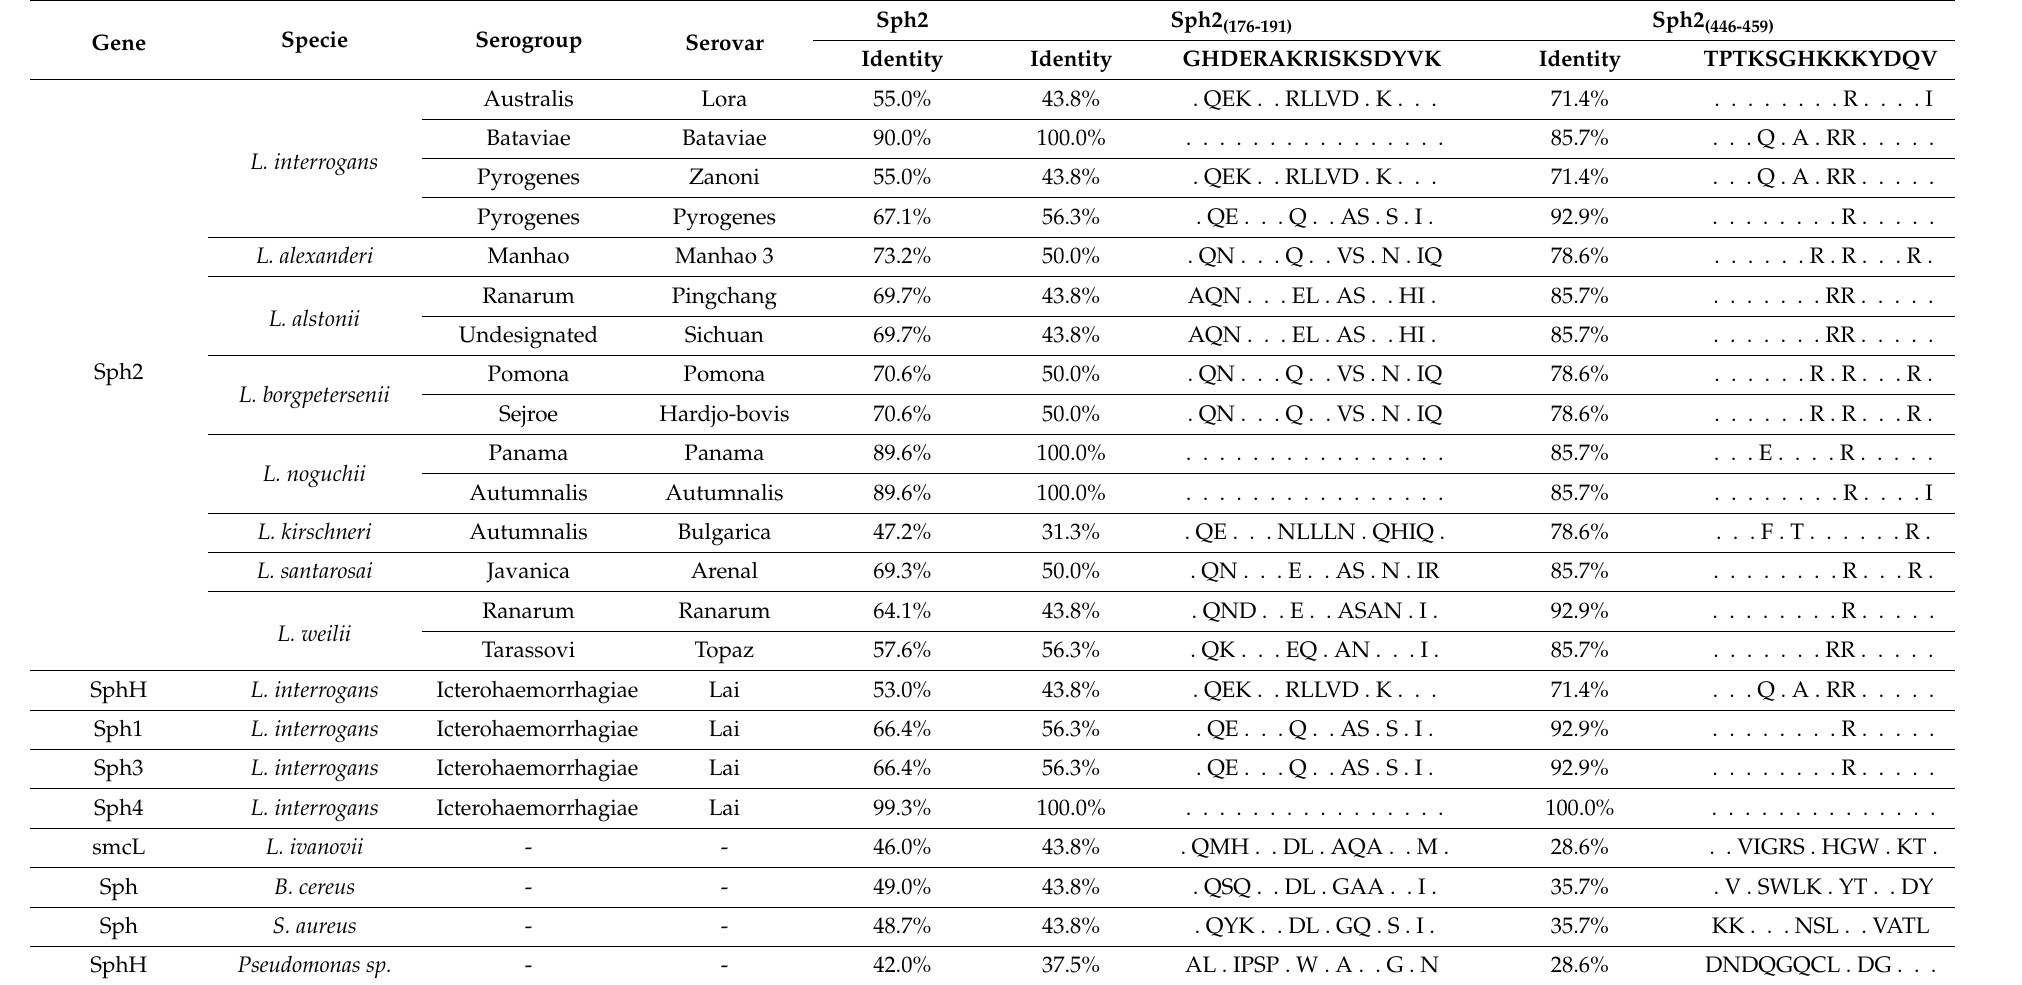
Table 3. Comparison of Sph2 and predicted epitopes among leptospires and other